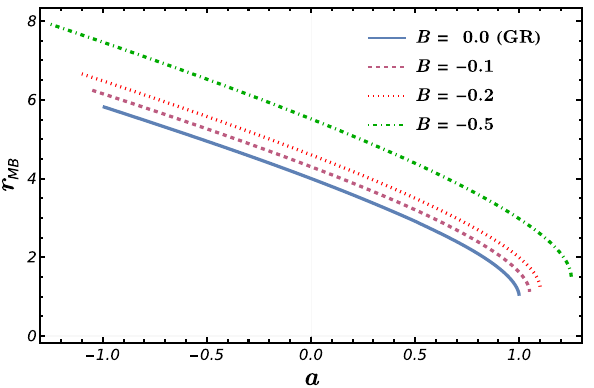
Fig. 4 Variation of marginally bound orbit as a function of spin of black hole for different B